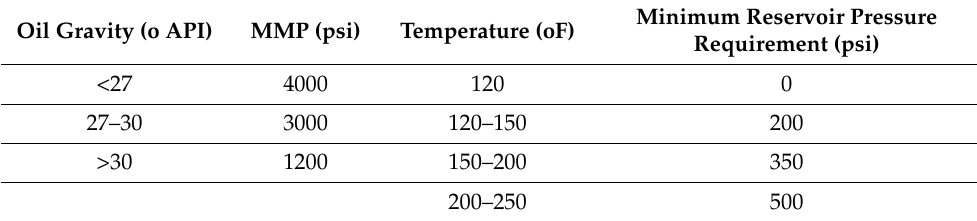
Table 4. Estimates of CO 2 -crude Oil Minimum Miscibility Pressure (MMP) Adapted from [103]. Oil Gravity (o API)